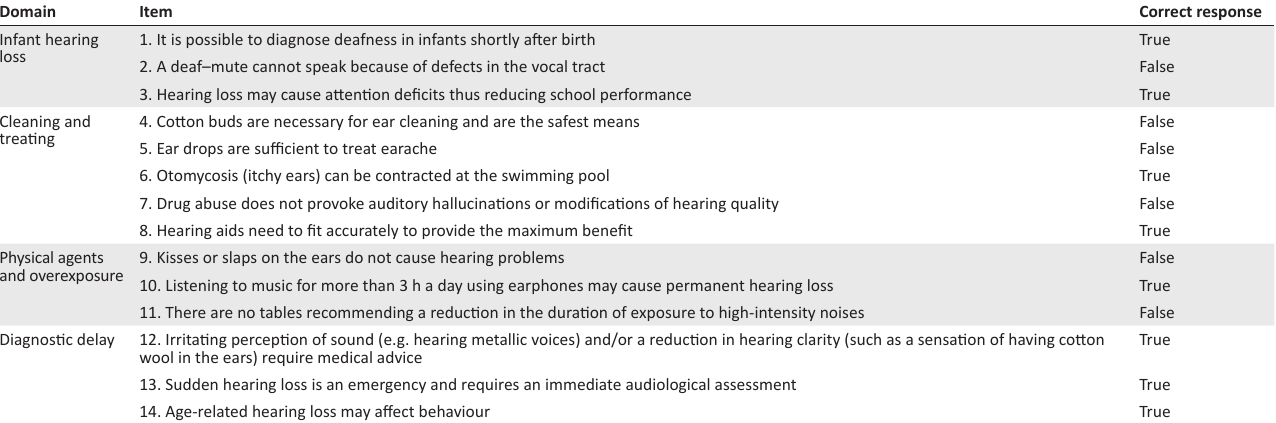
TABLE 1: Questionnaire to evaluate public awareness of ear and hearing management.